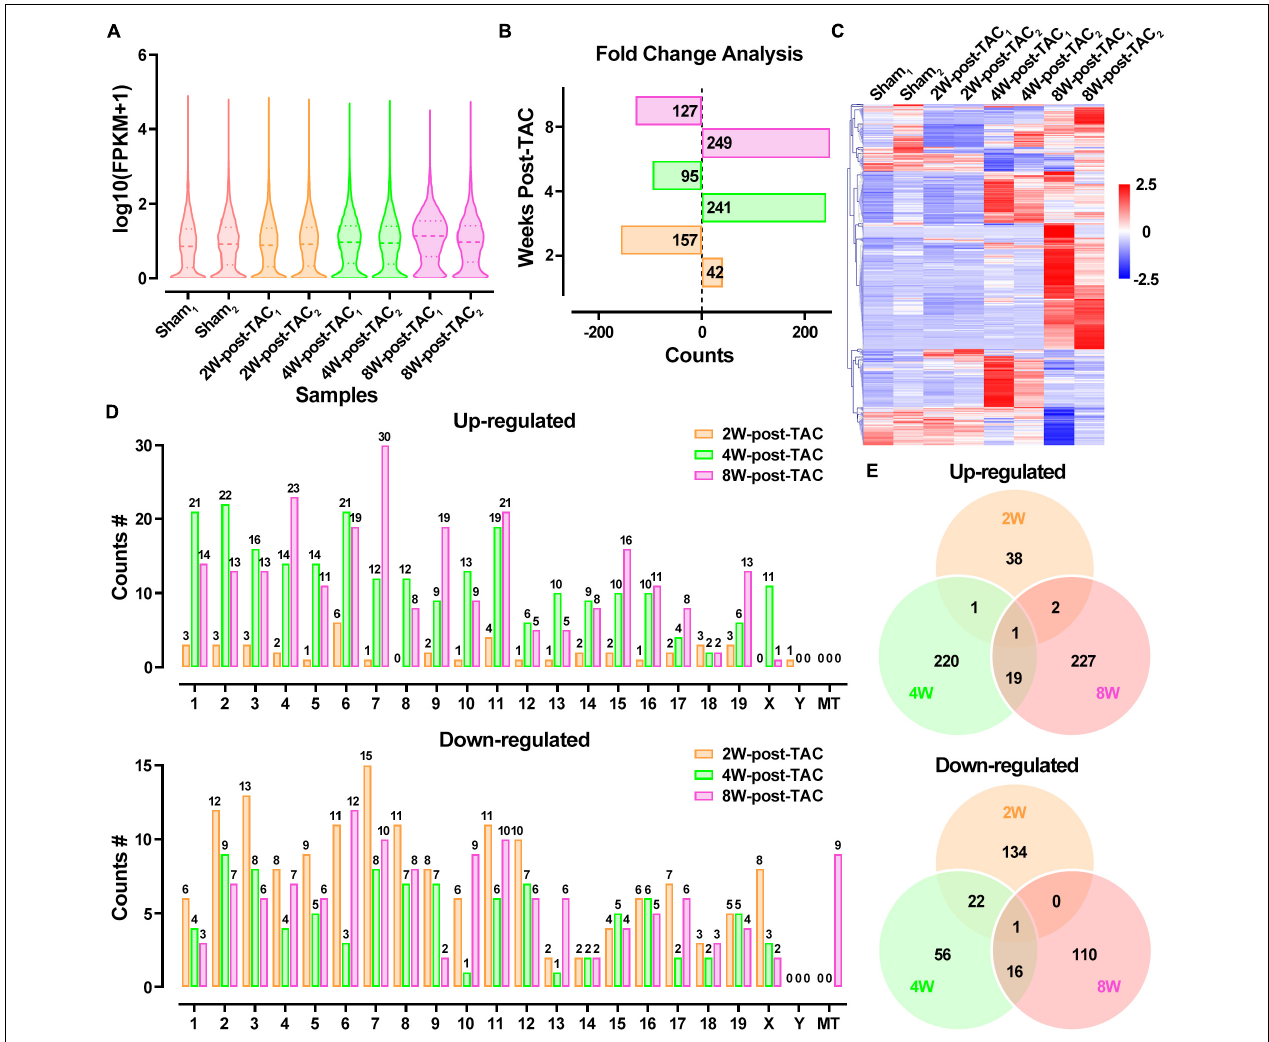
FIGURE 6 | Differential expression profiles of mRNAs in the murine post-TAC hearts. (A) The distributions of the total mRNAs in each sample. (B) Counts of up- and downregulated differential expressed genes (DEGs) in the 2W-, 4W-, and 8W-post-TAC groups. (C) Clustering heatmap plot of DEGs showed 24 main clusters for eight heart samples (two of each heart failure groups). Upregulated (red) or downregulated (blue) DEGs were distinguished from different heart failure stages. (D) The numbers of differentially expressed circRNAs (DECRs) distributed in murine chromosomes and mitochondria. (E) Venn diagrams illustrated the distinction and overlapping of the up- and downregulated differential expressed circRNAs in the in the 2W-, 4W-, and 8W-post-TAC groups. The cutoff for the DEGs was P < 0.05 and | log2FC | > 1. N = 2 for the sham, 2W-, 4W-, and 8W-post-TAC groups.